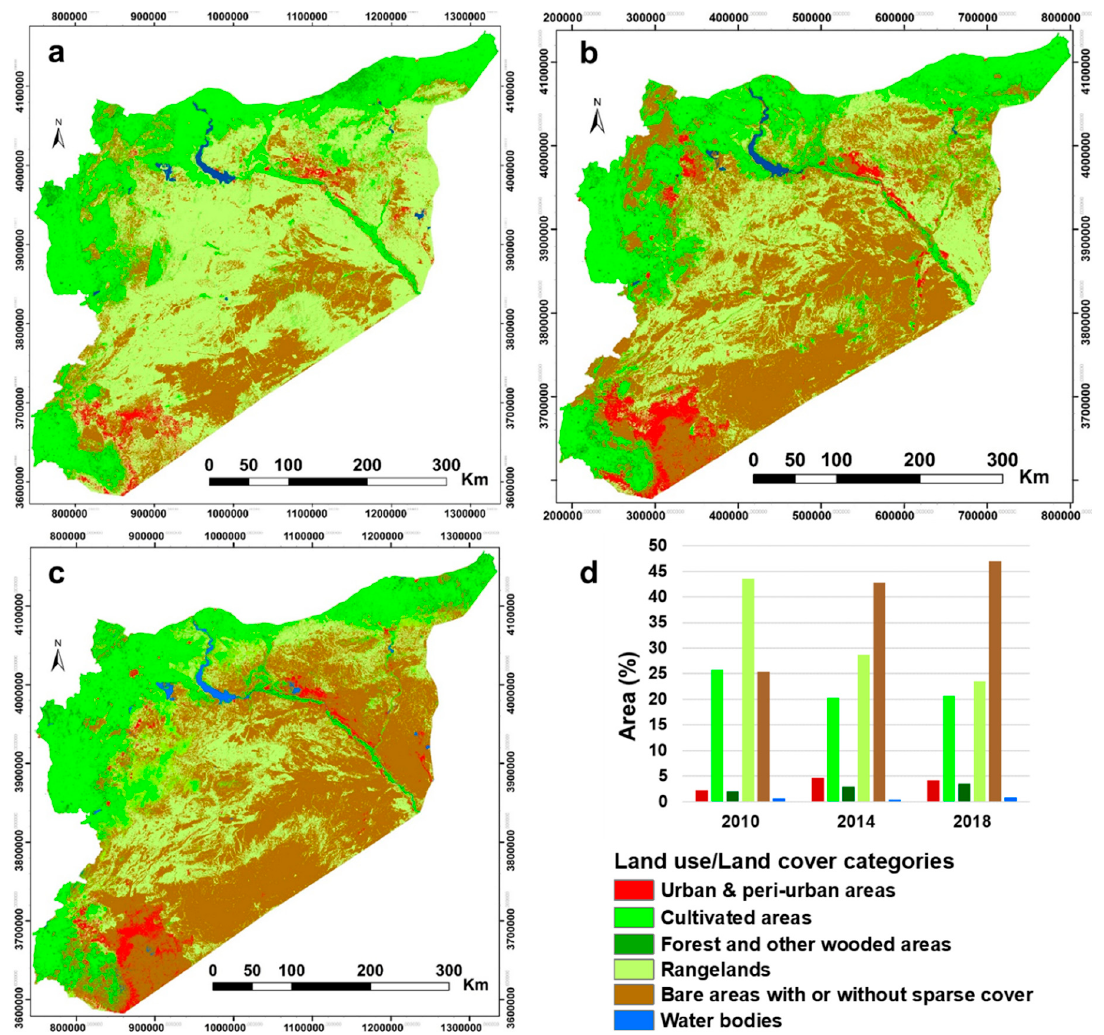
Figure 4. LULC maps of the study area Syria for 2010 ( a ), 2014 ( b ), and 2018 ( c ). The area (in %) of LULC categories after computing adjusted area estimates is given in ( d ).